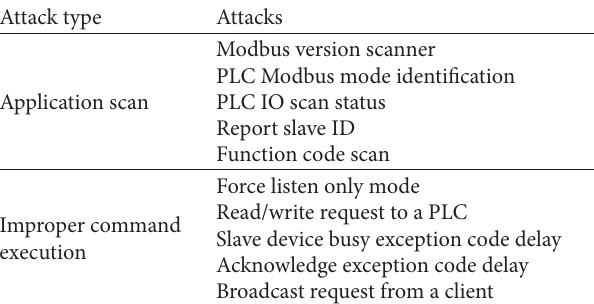
Table 2: Application protocol